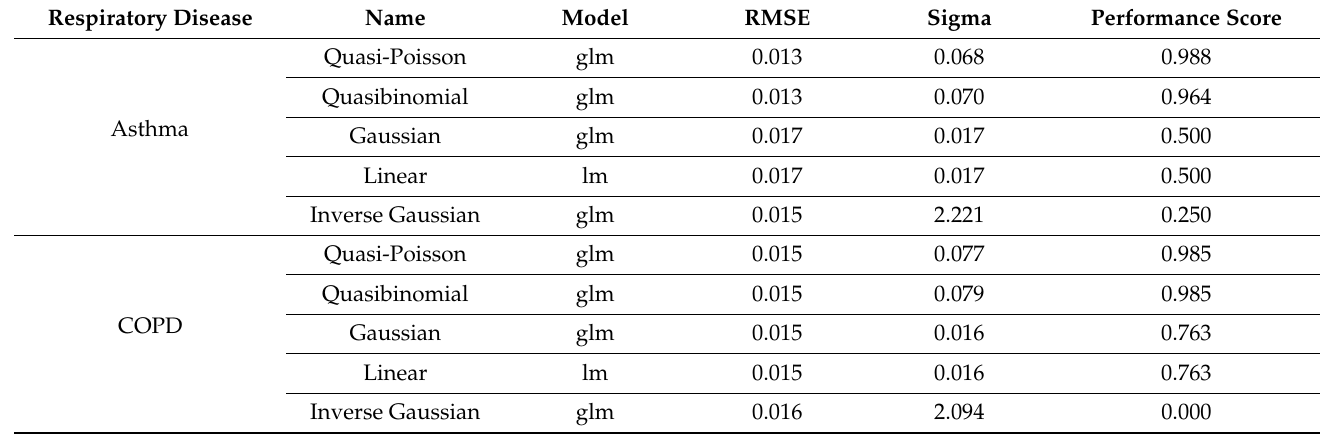
Table 1. Comparison of models from the different regression model families.